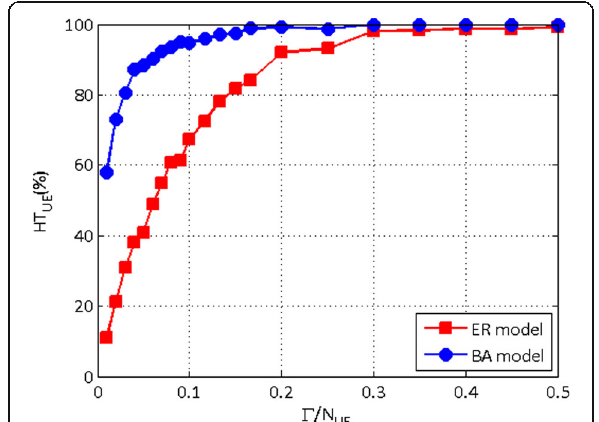
Fig. 14 Impact of percentage of content copies Γ / N UE to hit rate in